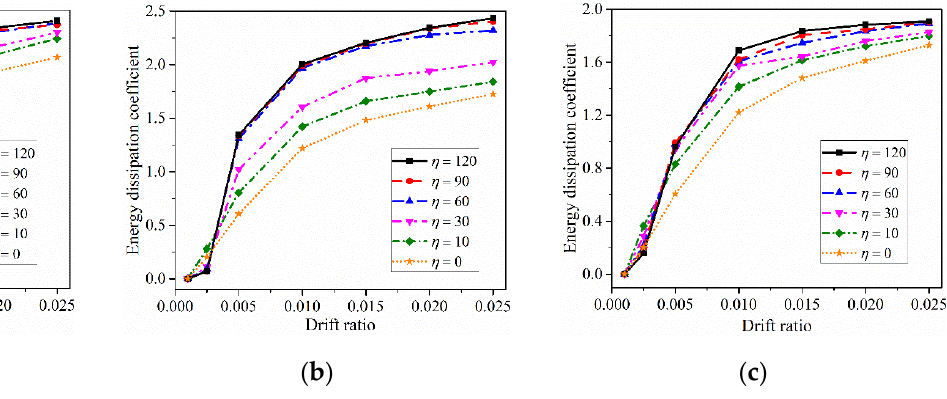
Figure 16. Energy dissipation coefficients of: ( a ) SPSW1 − 1VHS, ( b ) SPSW1 − 3VHS, and ( c ) SPSW1 − DS with different η . ( c ) SPSW1 − DS with different η